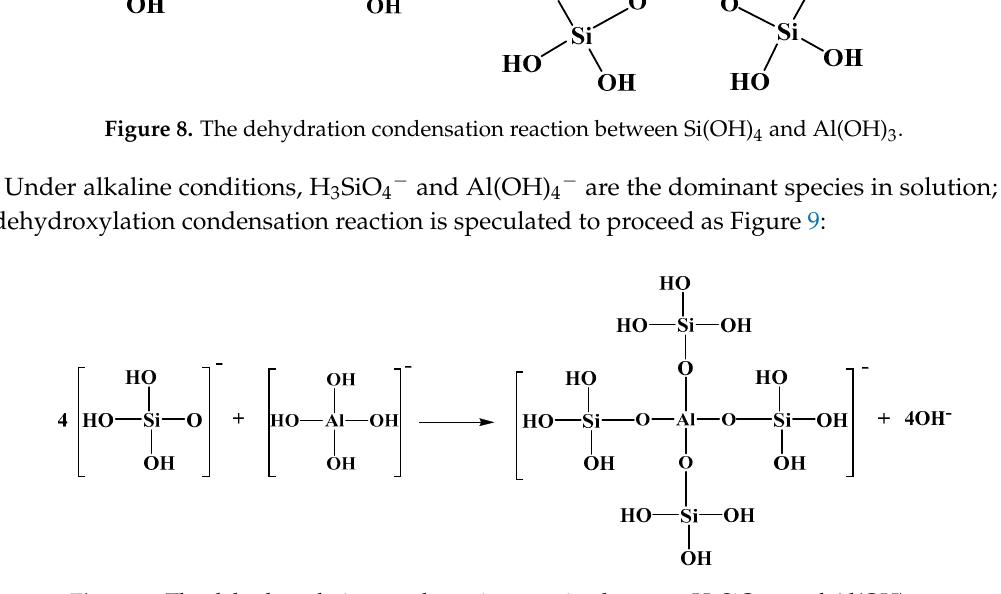
Figure 9. The dehydroxylation condensation reaction between H 3 SiO 4 − and Al(OH) 4 − .